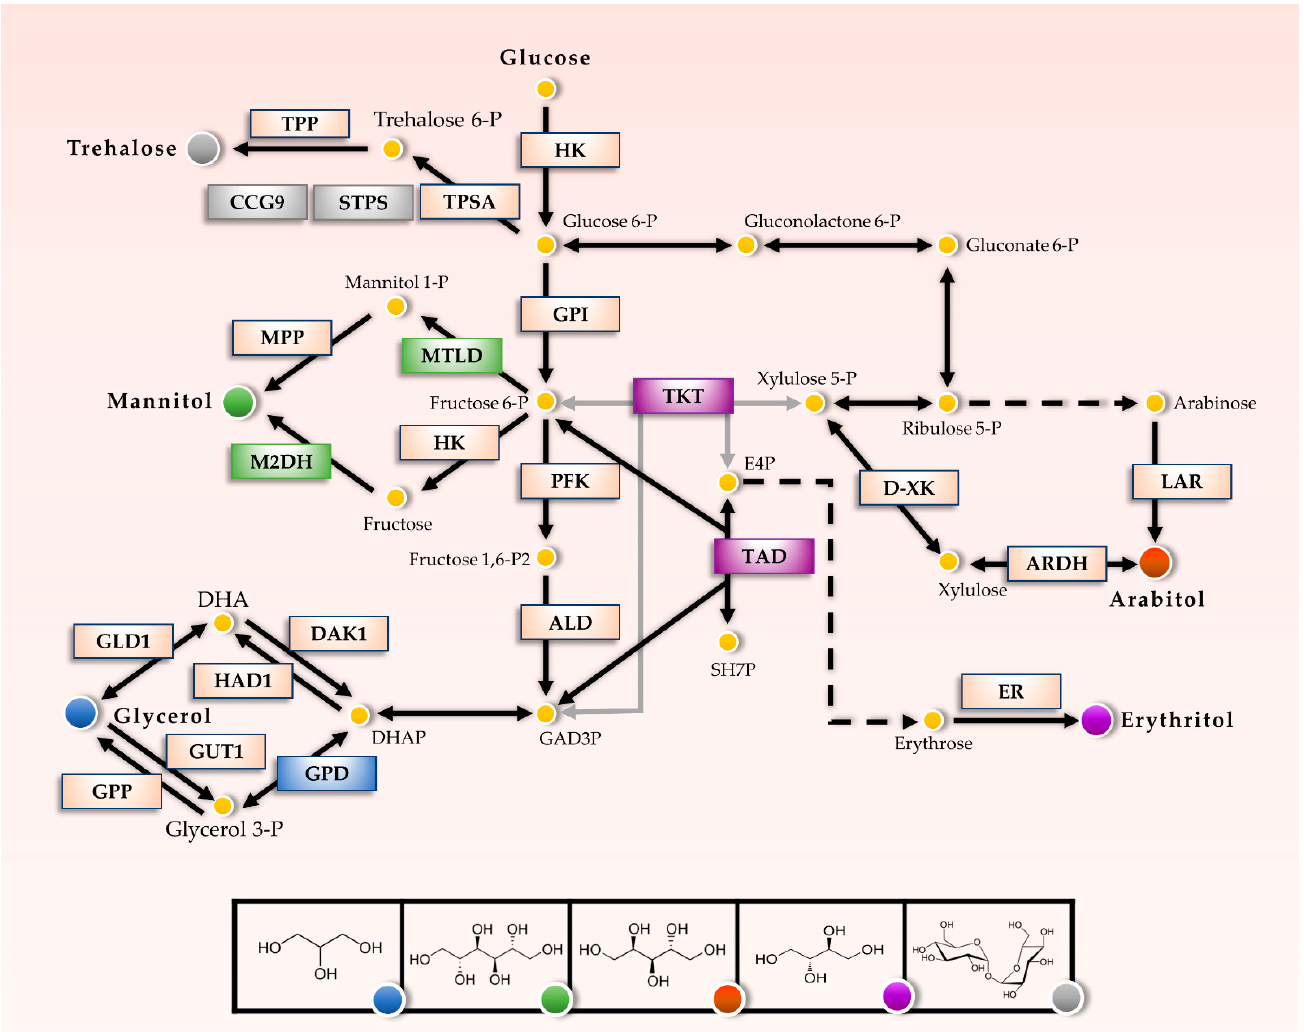
Figure 2. Pathways for the synthesis of metabolites with possible osmolyte functions in response to salinity. The pathway has been modified from the Aspergillus nidulans KEGG pathway. Enzymes involved in the regulation of osmolyte concentration and depicted with the color grey: trehalose pathway; green: mannitol; blue: glycerol; purple: erythritol, and red: arabitol were evaluated by qPCR. The enzymes depicted in light orange were not evaluated. TPSA (Trehalose phosphate synthase), STPS (Heat shock trehalose phosphate synthase), CCG-9 (Trehalose phosphate synthase), TPP (Trehalose-6-P phosphatase), MTLD (Mannitol-1-phosphate 5-dehydrogenase), M2DH (Mannitol 2-dehydrogenase), MPP (Manitol/Hexitol phosphatase), HK (Hexokinase), GPI (Phospho-glucose isomerase), PFK (Phospho-fructokinase), ALD (Aldolase), GPD (Glycerol-3-P dehydrogenase), GPP (Glycerol-3-P phosphatase), GUT1 (Glycerol-kinase), HAD1(Halo-acid dehalogenase), DAK1 (Dihydroxyacetone kinase) GLD1 (Glycerol dehydrogenase). TKT (Transketolase), TAD (Trans-aldolase), LAR (L-arabinose), ARDH (L-arabinitol dehydrogenase), D-XK (D-Xylose Kinase), ER (Erythrose reductase).